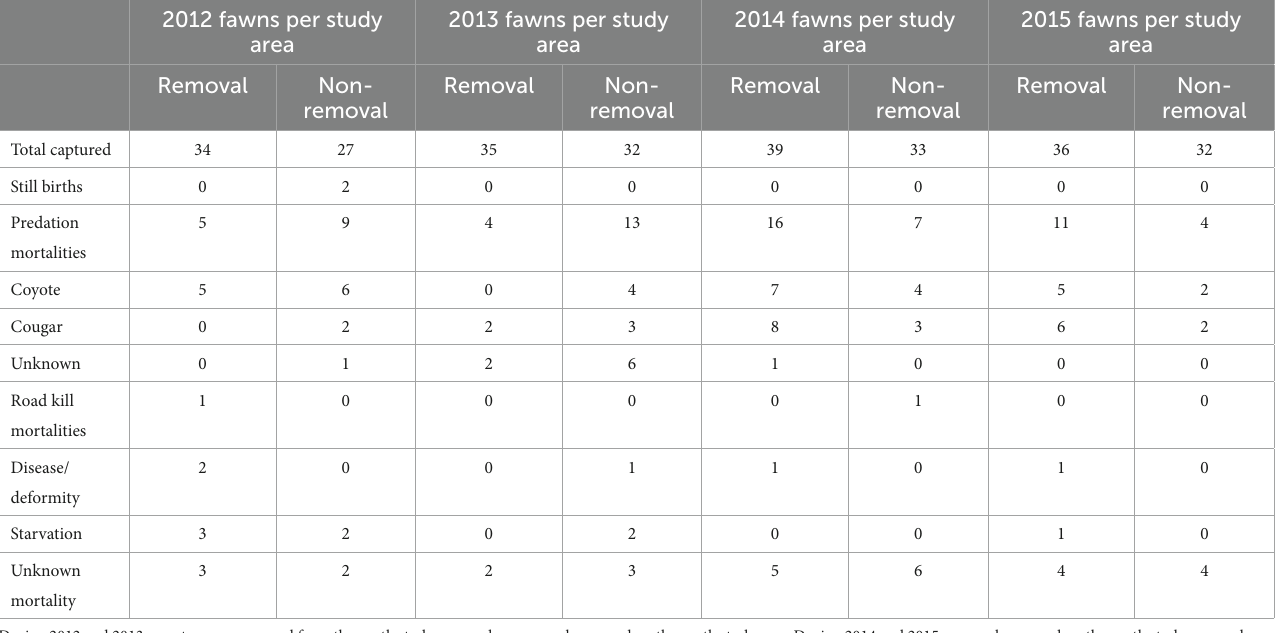
TABLE 2 The distribution and probable causes of mortality of neonate mule deer that were captured on Monroe Mountain, Utah during